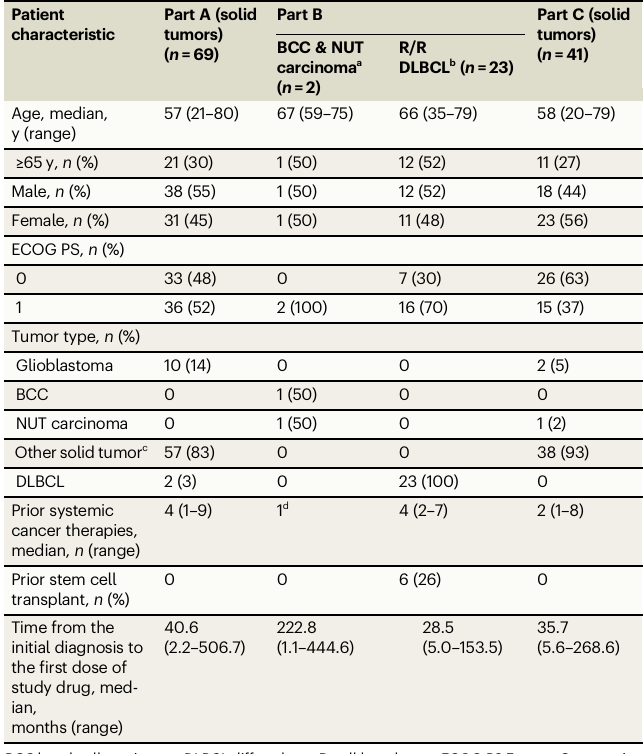
Table 1 | Baseline patient demographics and characteristics for parts A, B, and C of the CC-90010-ST-001 study Patient